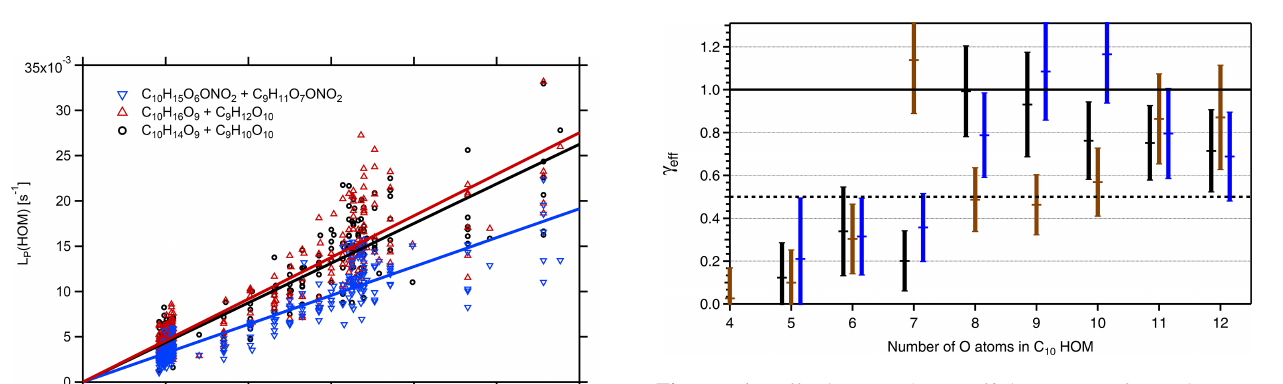
Figure 6. Effective uptake coefficients γ eff for HOM-PPs (C 10 H 14 O x black bars, C 10 H 16 O x , brown bars) and HOM-ONs (C 10 H 15 O x NO 2 , blue bars) as a function of the number of O atoms in the respective HOM. HOMs with different numbers of C, H, and O atoms, e.g., C 10 H y O x and C 9 H y − 4 O x + 1 HOM-PPs, are treated together, and the number of O atoms is given for the C 10 -HOM- PPs. The second component, C 9 -HOM-PPs, has one O atom more. Data were taken from the β -pinene photooxidation experiment with [ β -pinene] SS ∼ 10ppb, [NO x ] SS ∼ 4ppb. The signal intensity for the C 10 H 14 O 4 and HOM-ONs with four O atoms was too low to allow reliable determination of γ eff , and the respective data are left out. Uncertainties in γ eff arise from the determination procedure as shown in Fig. 5. The black line indicates γ eff = 1 and 0.5. An av- erage Fuchs–Sutugin correction factor of 0.70 ( d p = 175nm) was applied to calculate γ eff